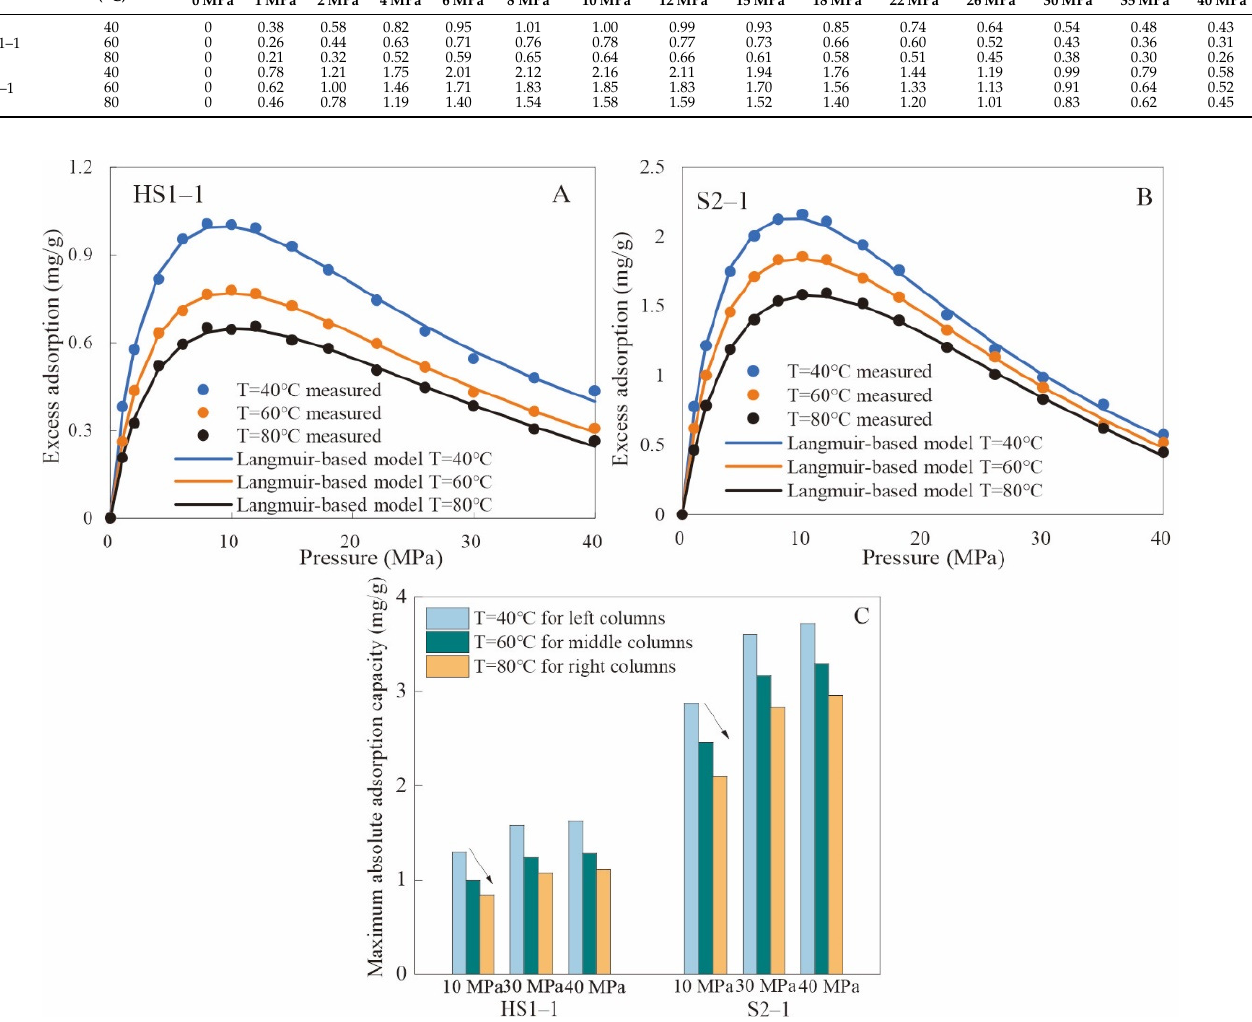
Figure 5. Measured adsorbed amount and Langmuir-model-fitted excess adsorption isotherms of CH 4 ( A , B ), comparison of maximum absolute adsorption capacities of CH 4 fitted by Langmuir-based excess adsorption model based on data of 10, 30, and 40 MPa ( C ).